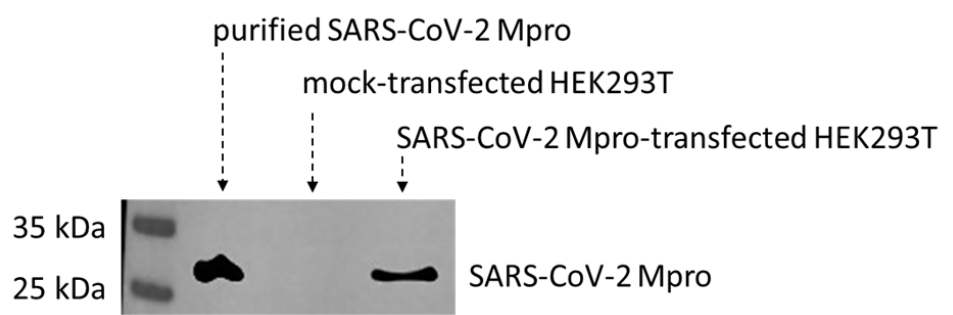
absent from the lysate of the mock-transfected cells (Figure 1). Purified SARS-CoV-2 Mpro was used as a positive control [12].